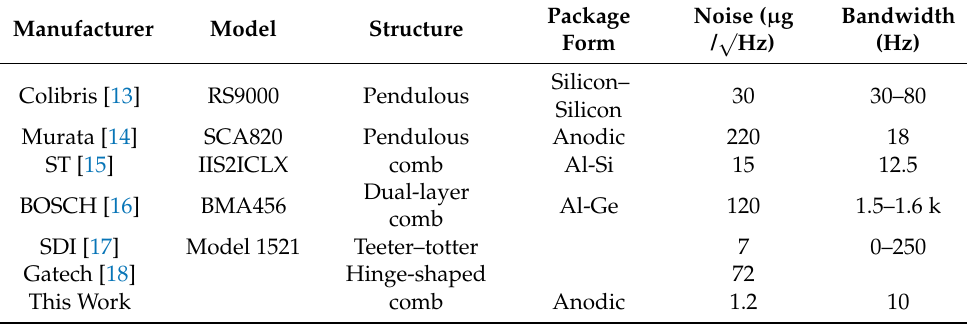
Table 1. Comparison of parameters about MEMS accelerometers for inclination detection.